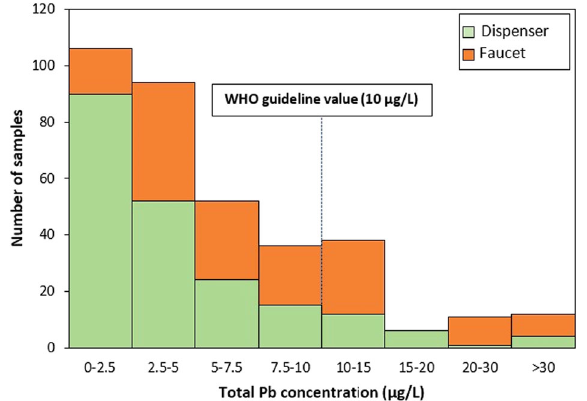
Fig. 1 Pb levels in water samples. Distribution of Pb levels in water samples collected from POU dispensers ( n = 204) and faucets ( n = 354). Dotted line refers to the WHO guideline value of 10 μ g/L for Pb in drinking